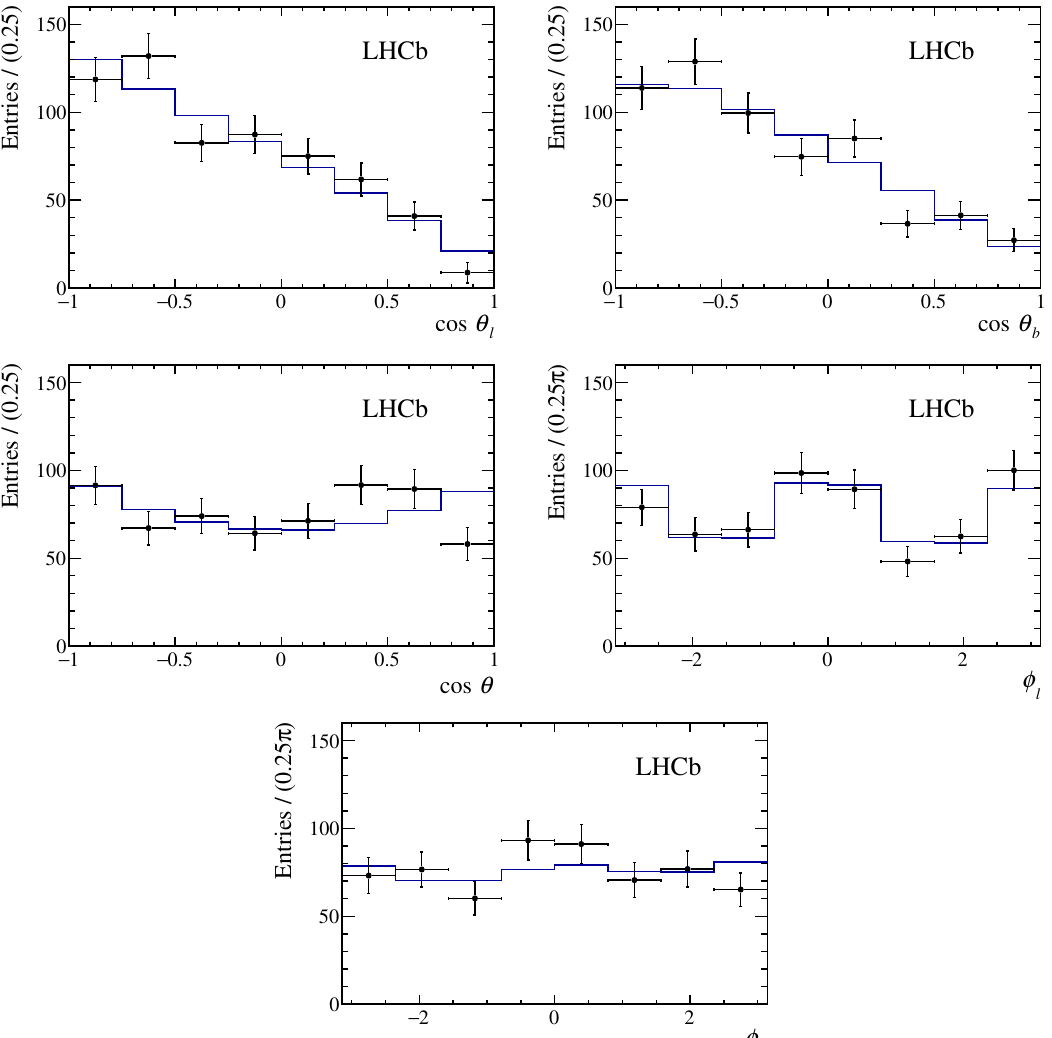
Figure 2 . One-dimensional projections of the angular distributions of the candidates (black points), combining Run 1 and Run 2 data, as well as candidates reconstructed in the long- and downstream- track p(cid:25) (cid:0) categories. The background is subtracted from the data but no e(cid:14)ciency correction is applied. The projection of each angular distribution obtained from the moment analysis multiplied by the e(cid:14)ciency distribution is superimposed. The large variation in (cid:30) ‘ is primarily due to the angular acceptance.